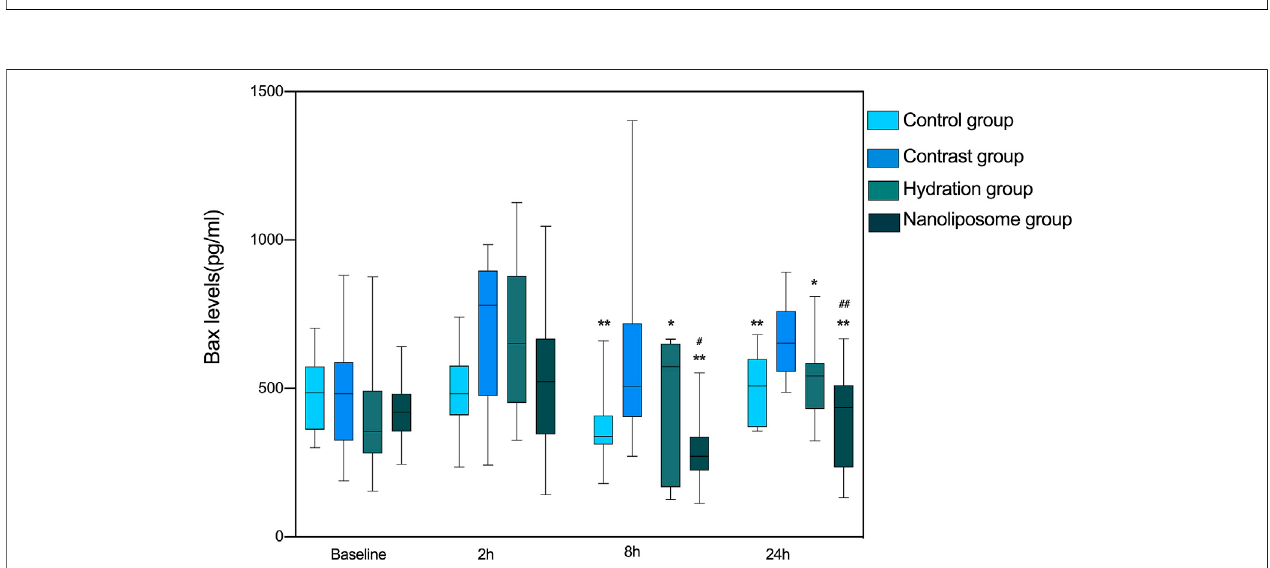
FIGURE 4 | The contents of apoptosis index Bax in four groups were detected by ELISA. Bax: Bcl-2 subfamily, pro-apoptotic factor. Values are expressed as mean ± SD.*Comparedwiththecontrastgroup, p < 0.05.**Comparedwiththecontrastgroup, p < 0.01. # Comparedwiththehydrationgroup, p < 0.05. ## Comparedwith the hydration group, p <